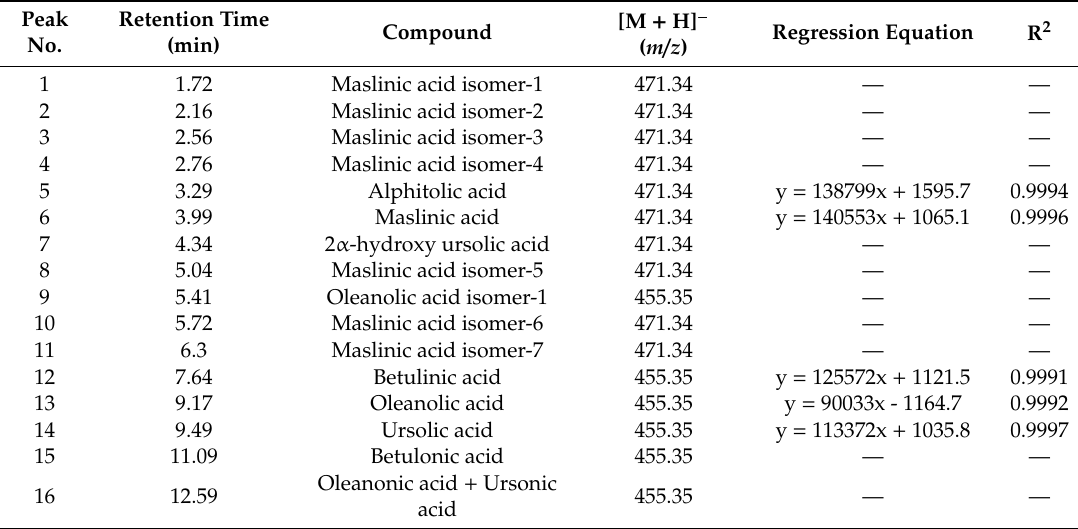
Table 3. The retention time, mass spectrum (MS) parameters, and regression equations of standards and